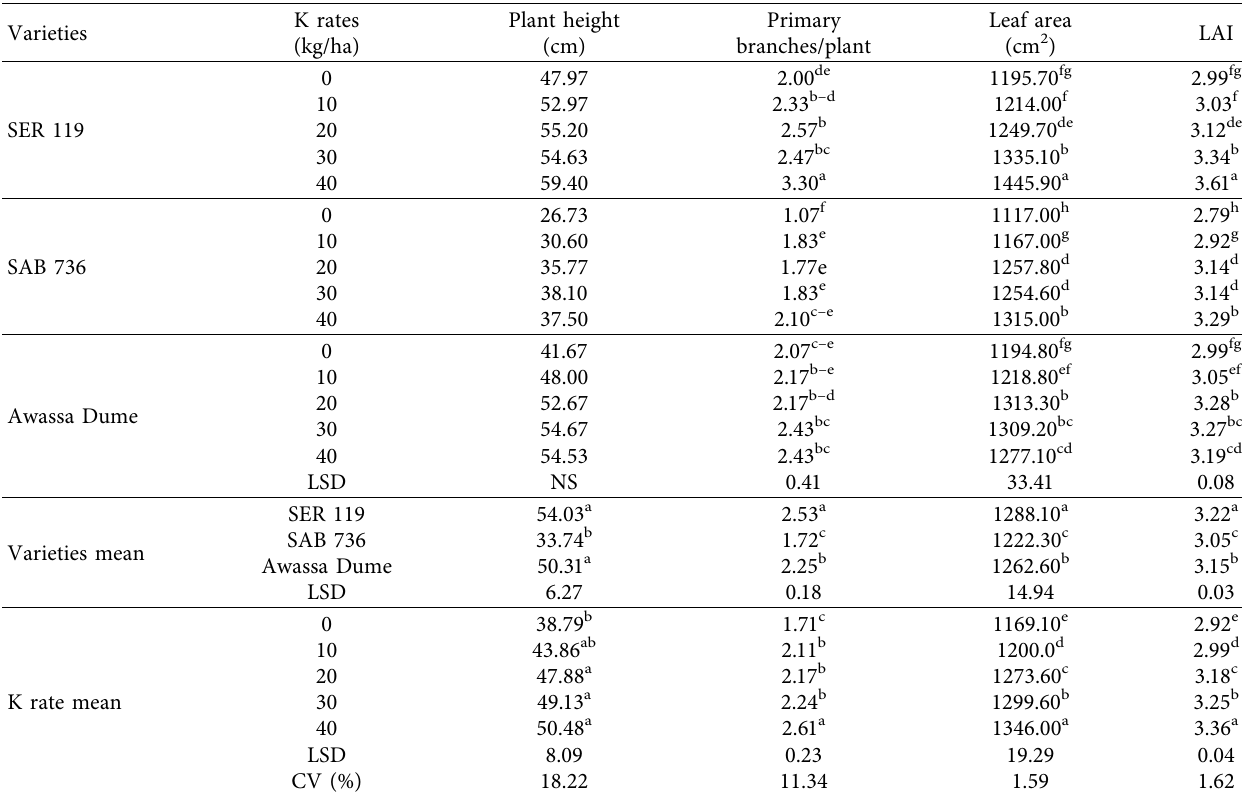
Table 2: Plant height, primary branches, leaf area, and LAI as afected by varieties and K rates during 2019/20 cropping seasons.